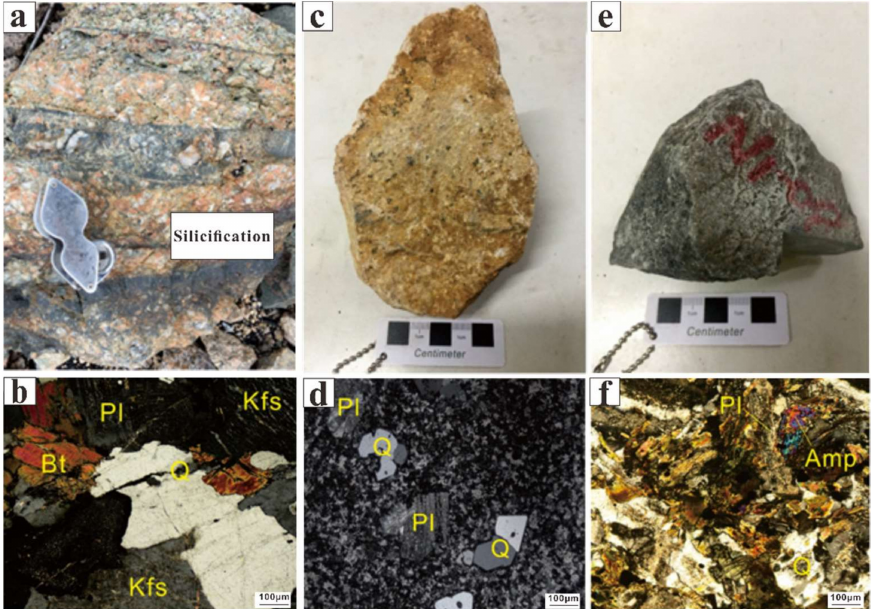
Figure 3. Photos and photomicrographs of representative granite from the Nianzigou district. ( a ) Bi- otite monzogranite, ( b ) Biotite monzogranite under cross-polarized light; ( c ) Granite porphyry dyke, ( d ) Granite porphyry dyke under cross-polarized light; ( e ) Diorite porphyrite dyke, ( f ) Diorite por- phyrite dyke under cross-polarized light. Kfs = K-feldspar, Pl = plagioclase, Bt = biotite, Q = quartz, Amp =